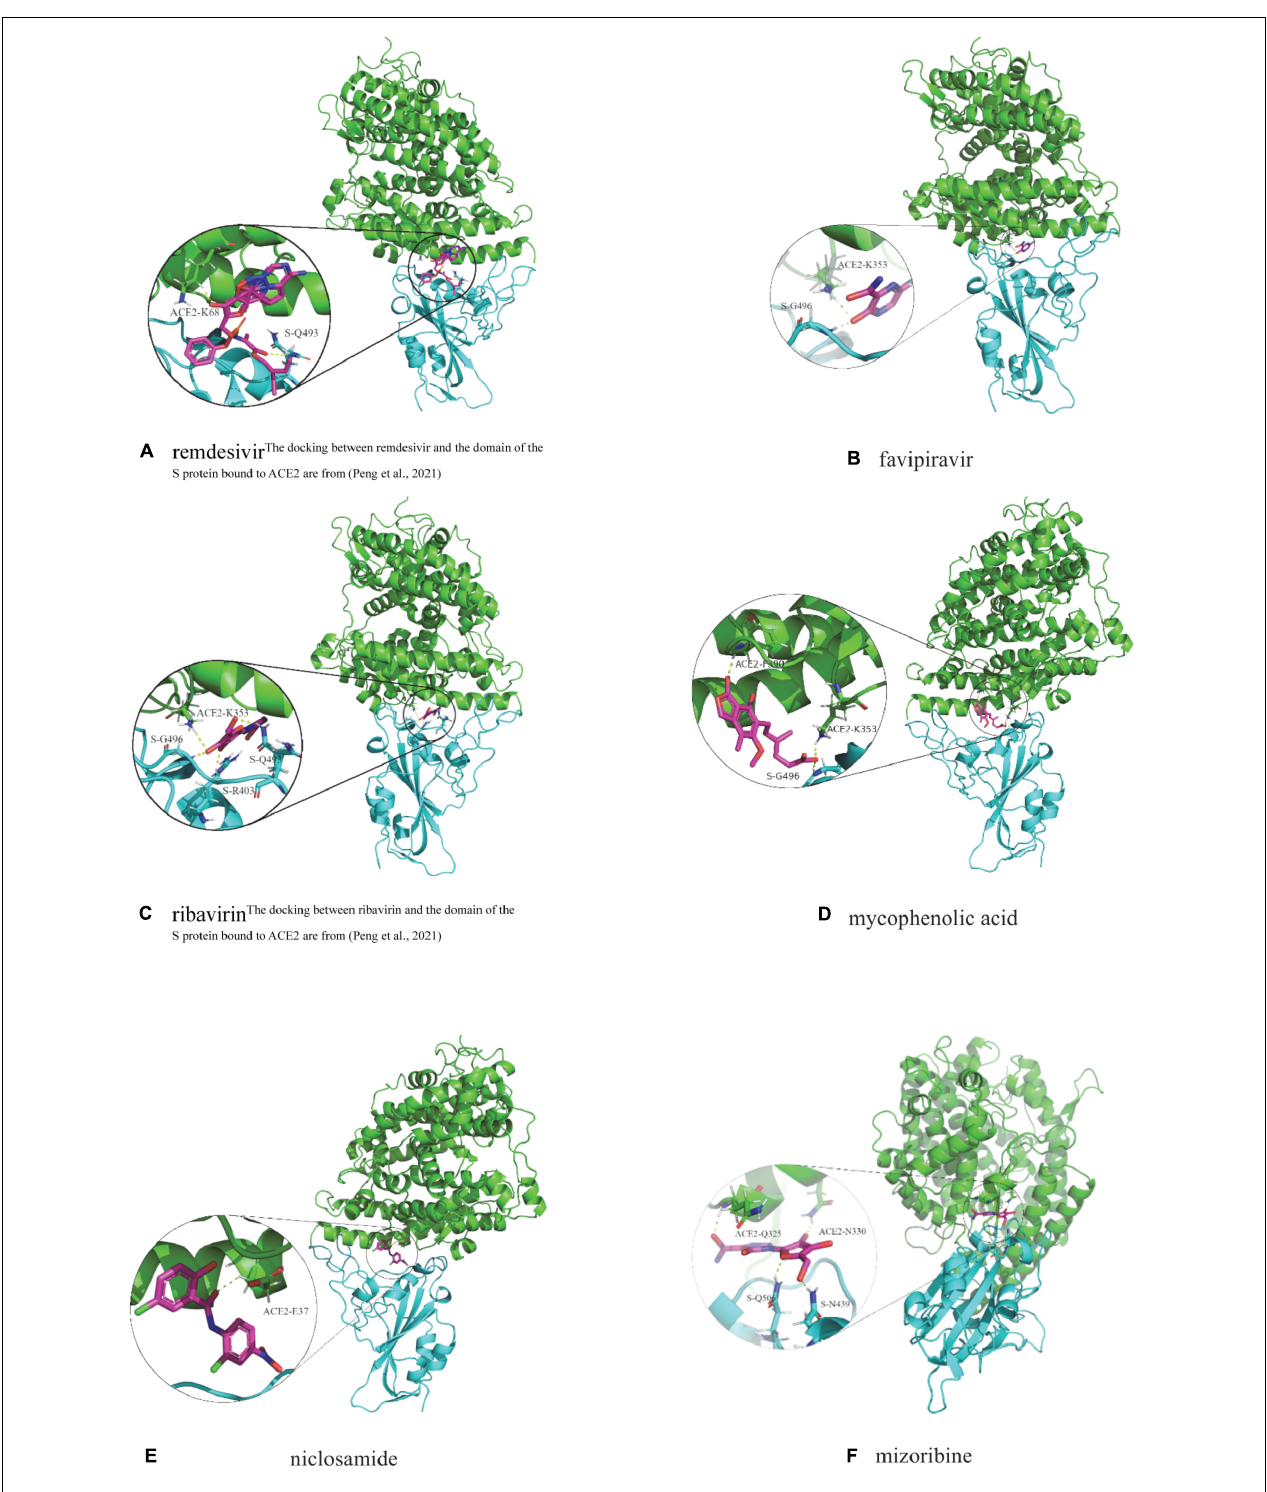
FIGURE 4 | Molecular docking between the predicted six anti-SARS-CoV-2 drugs and the domain of the S protein binding to ACE2. (A) Remdesivir (the docking between remdesivir and the domain of the S protein bound to ACE2 are from Peng et al., 2021). (B) Favipiravir. (C) Ribavirin (the docking between remdesivir and the domain of the S protein bound to ACE2 are from Peng et al., 2021). (D) Mycophenolic acid. (E) Niclosamide. (F) Mizoribine.